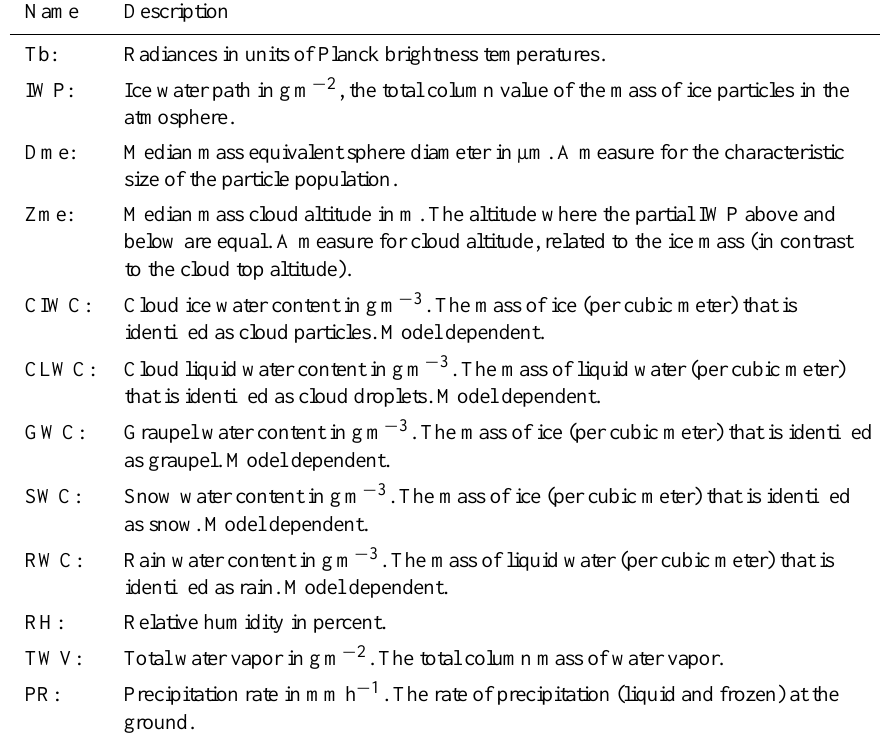
Table 5. Data product